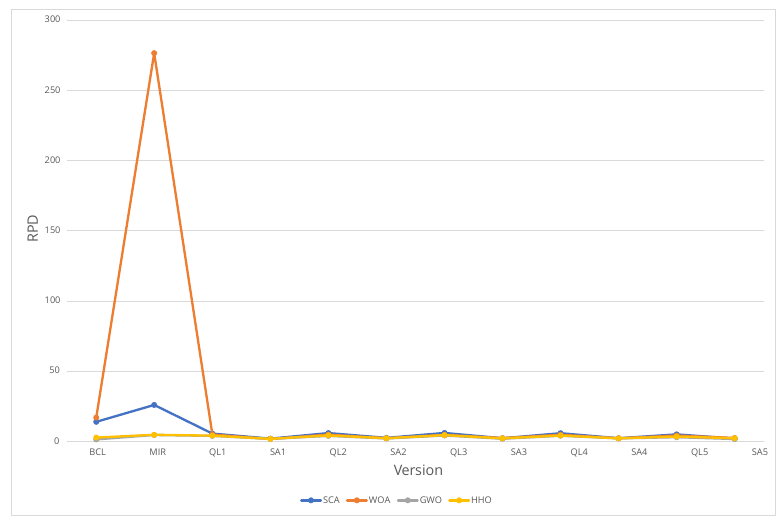
Figure 24. The average RPD.